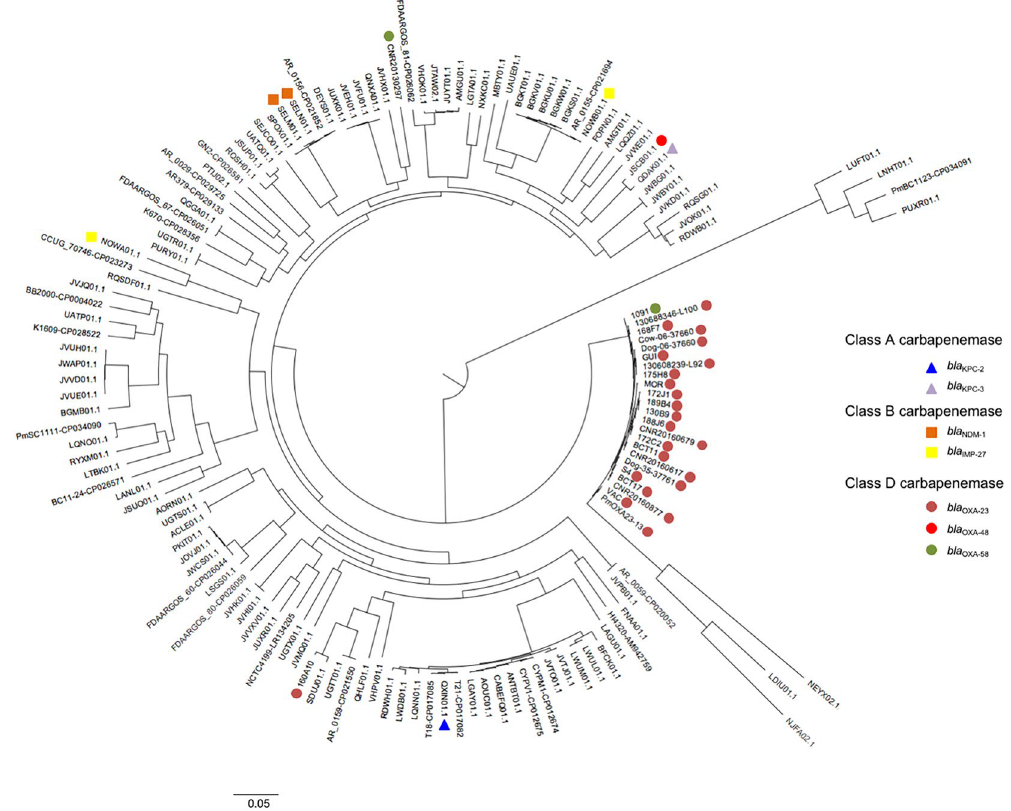
Figure 3. Phylogenetic relationship of the 24 OXA-23 and OXA-58-producing P. mirabilis isolates with 121 reference genomes of P. mirabilis from GenBank. The phylogenetic tree was obtained using CSI phylogeny v1.4 43 . Carbapenemase producing isolates are labelled with their respective coloured